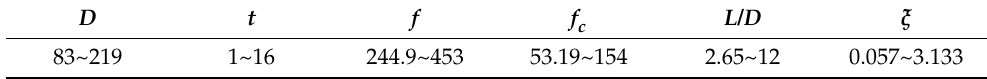
Table 6. Parameter range of tested